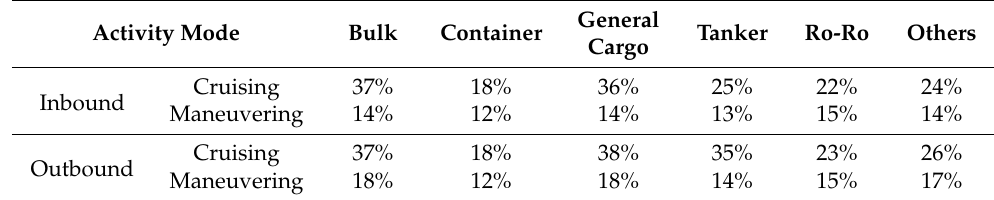
Table 5. The load factor of the main engine by ship type based on ship’s speed by propeller law.